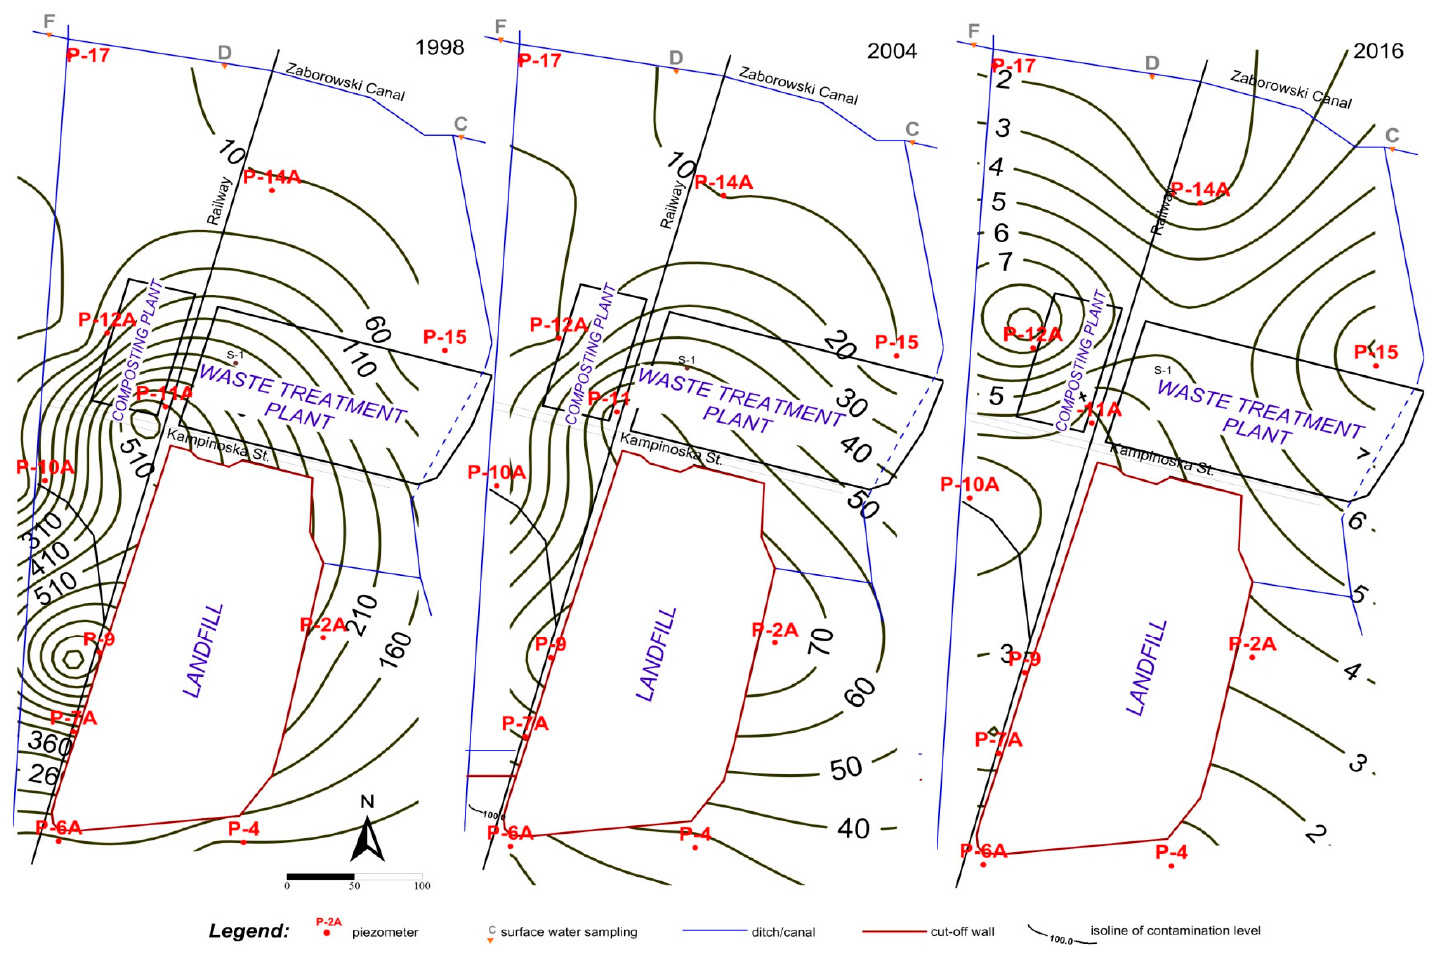
Figure 3. Distribution of the mean values of the biochemical oxygen demand (BOD) in groundwater in 1998, 2004 and 2016.